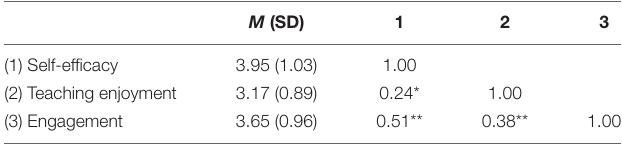
TABLE 2 | Descriptive statistics and